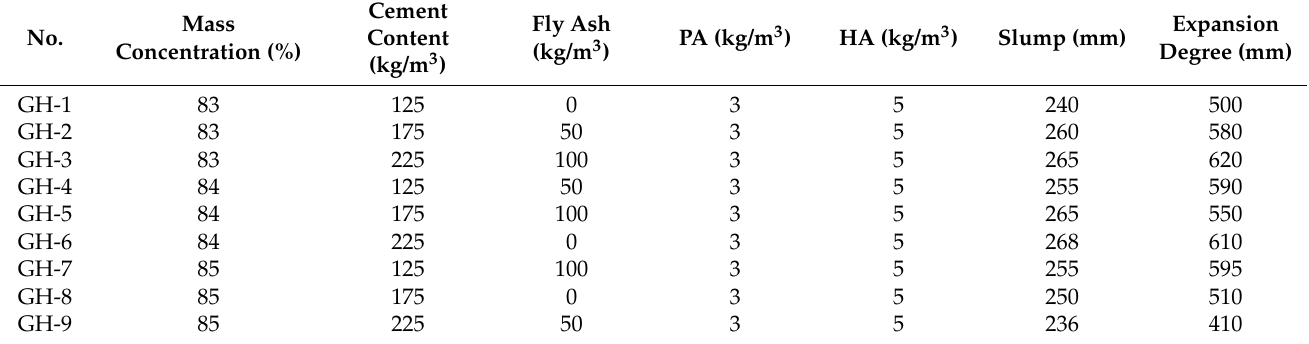
Table 5. Orthogonal test